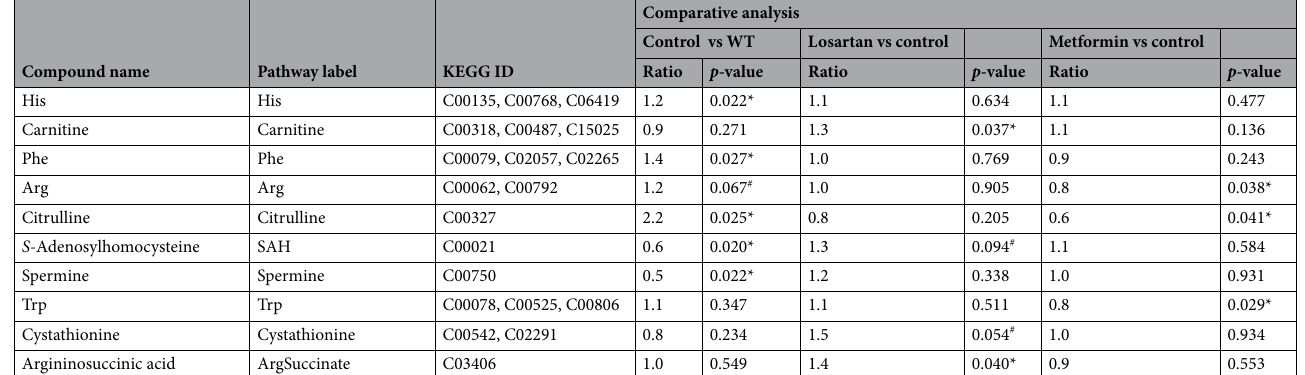
Table 1. Altered metabolite in Alport vehicle (control), Alport losartan and Alport metformin. N.A. Not available. Subject to calculation, but calculation was not possible due to insufficient data. The ratio of the mean values between the two groups is calculated using the latter as the denominator. The p-values was calculated by Welch’s t-test ( # < 0.1, *< 0.05, **< 0.01, ***<